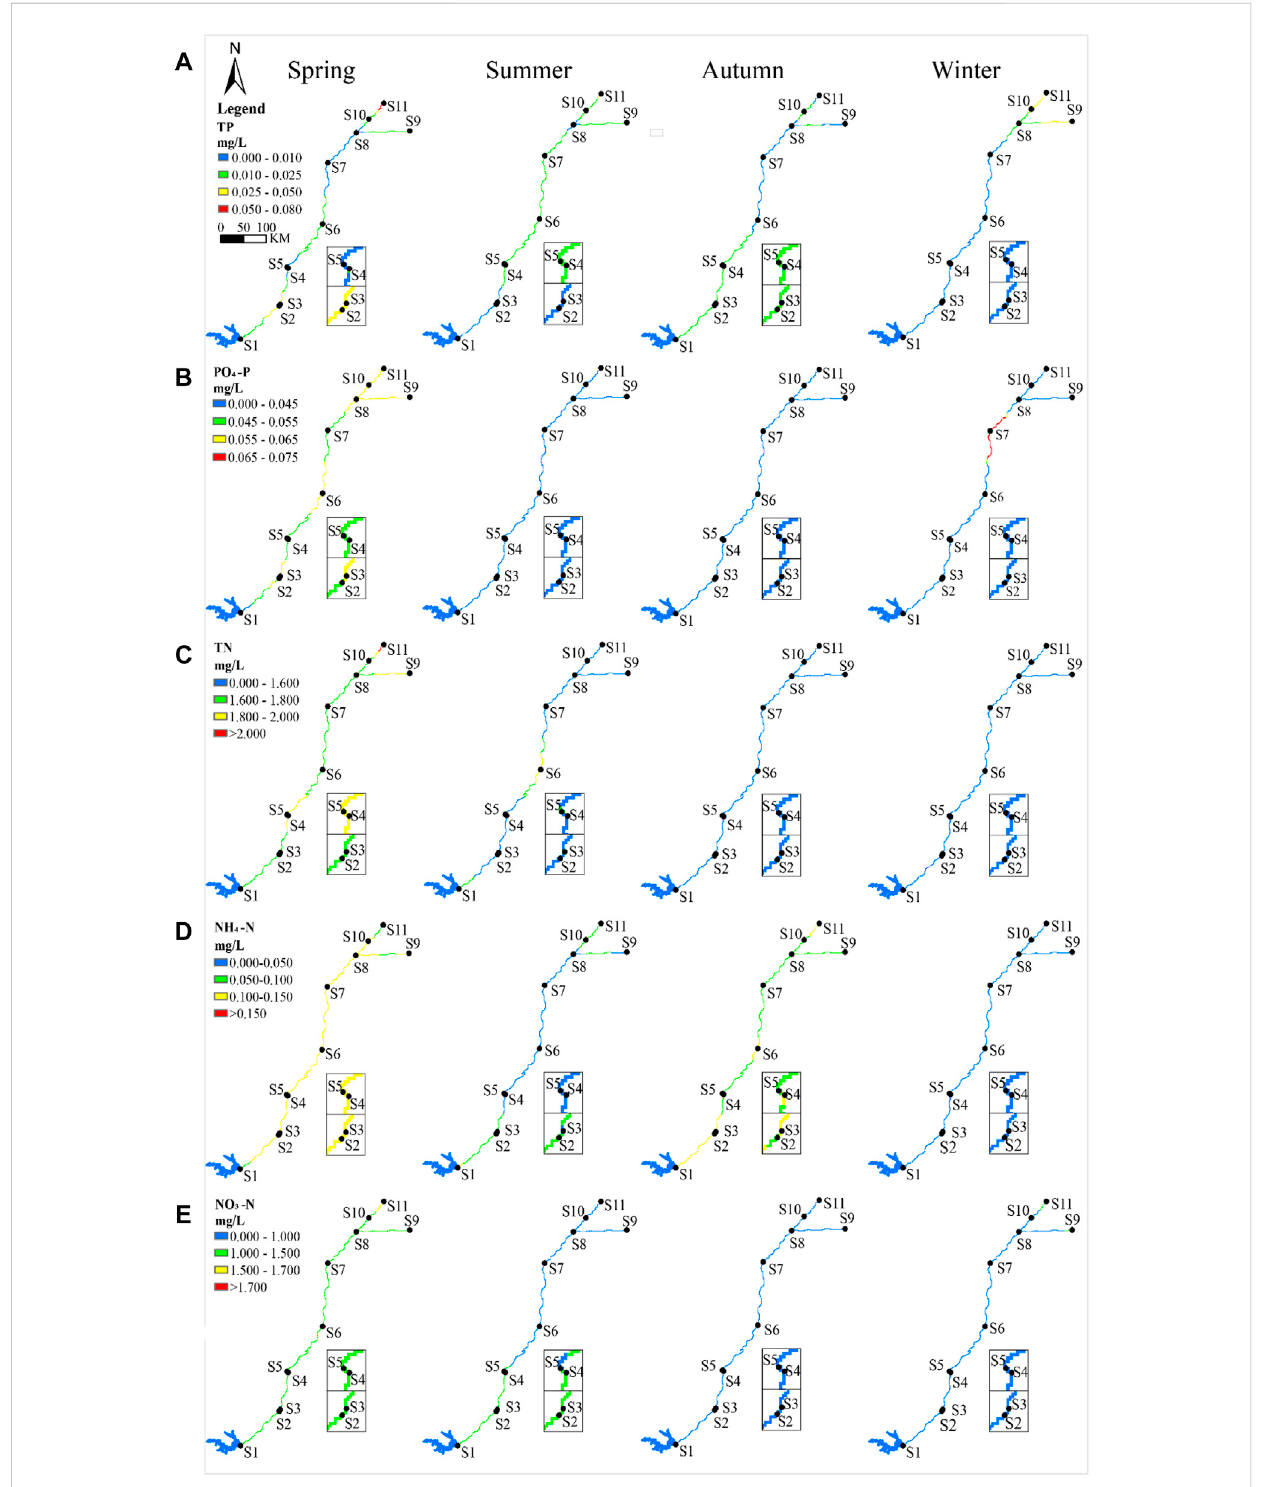
FIGURE 3 Spatio-temporal distribution of phosphorus and nitrogen in the middle route of South-to-North Water Diversion Project. (A) Spatio-temporal distributionofTP; (B) spatio-temporaldistributionofPO 4 -P; (C) spatio-temporaldistributionofTN; (D) spatio-temporaldistributionofNH 4 -N; (E) spatio- temporal distribution of NO 3